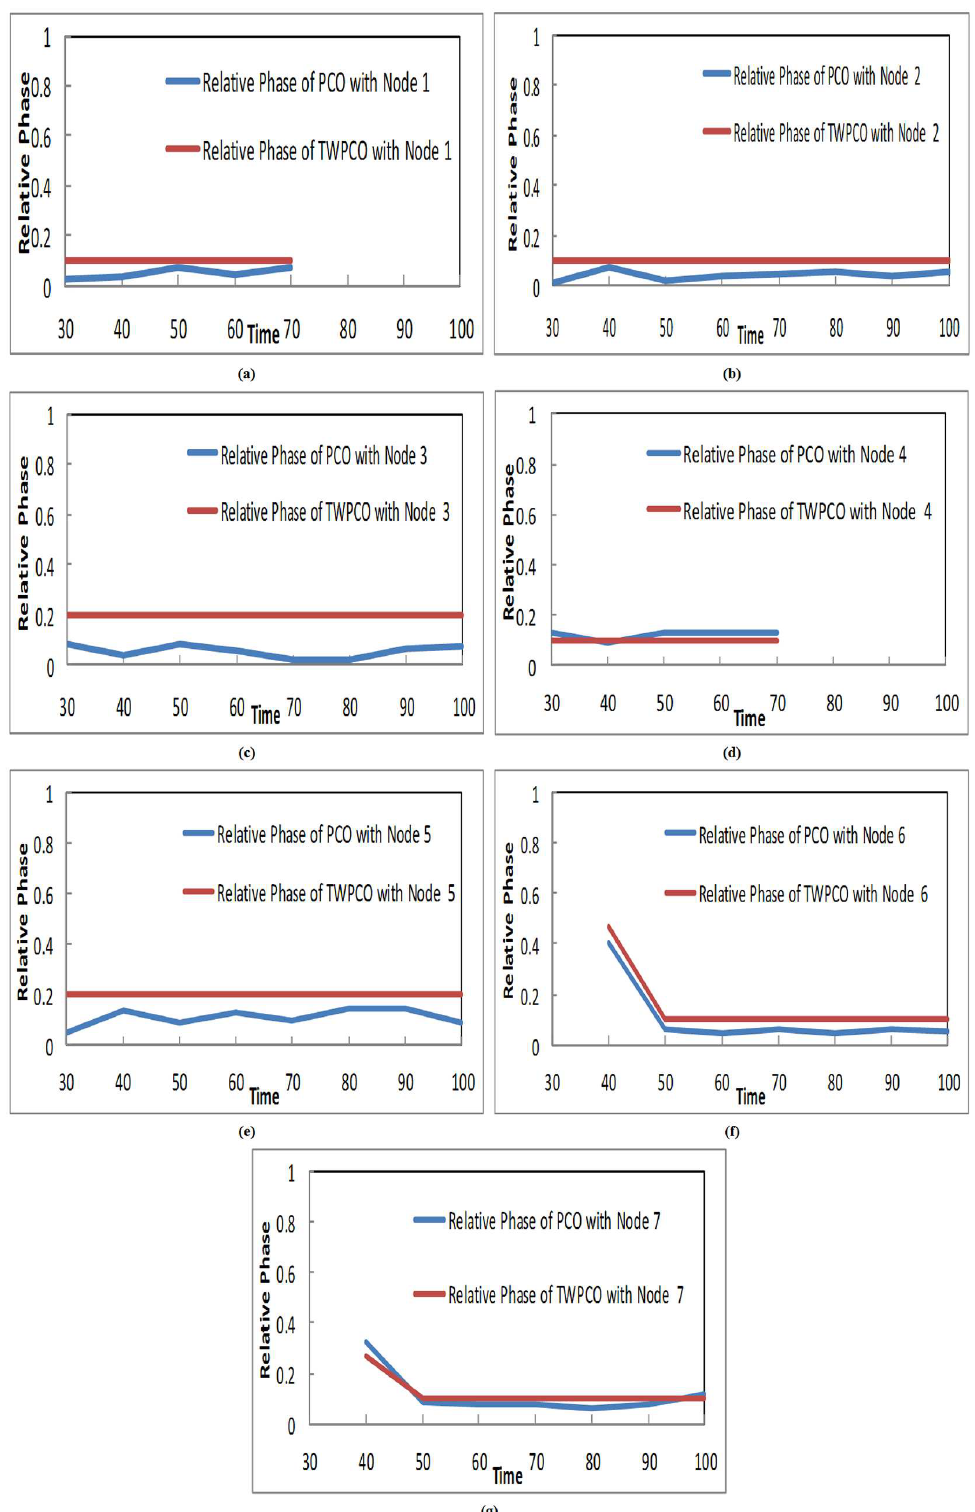
Fig 12. Evaluation of Relative Phase under the TWPCO and PCO Schemes for Sensor Nodes against the Addition and Removal of Sensor Nodes.